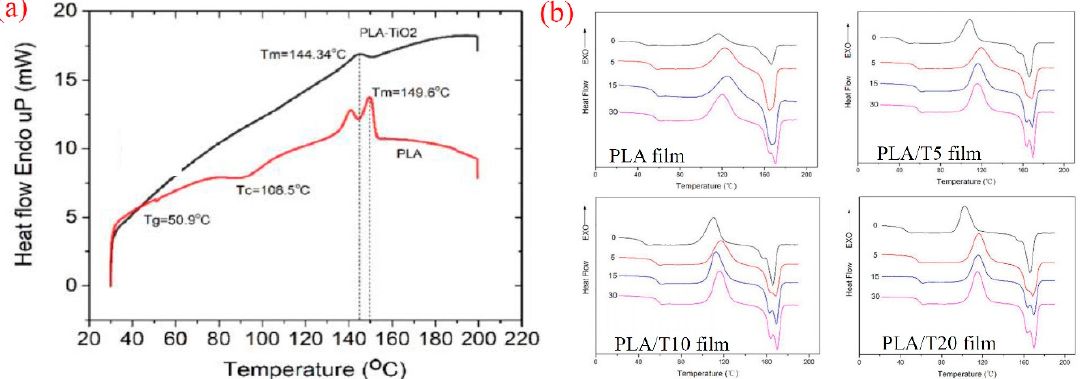
Figure 5. ( a ) Differential scanning calorimetry (DSC) curve of pure PLA and PLA/TiO 2 composites and ( b ) DSC curves of PLA, PL / T5, PLA / T10, and PLA / T20 composite films contacting with ethanol [31] and ( b ) DSC curves of PLA, PL/T5, PLA/T10, and PLA/T20 composite films contacting with ethanol as food simulant at different period of time [32].